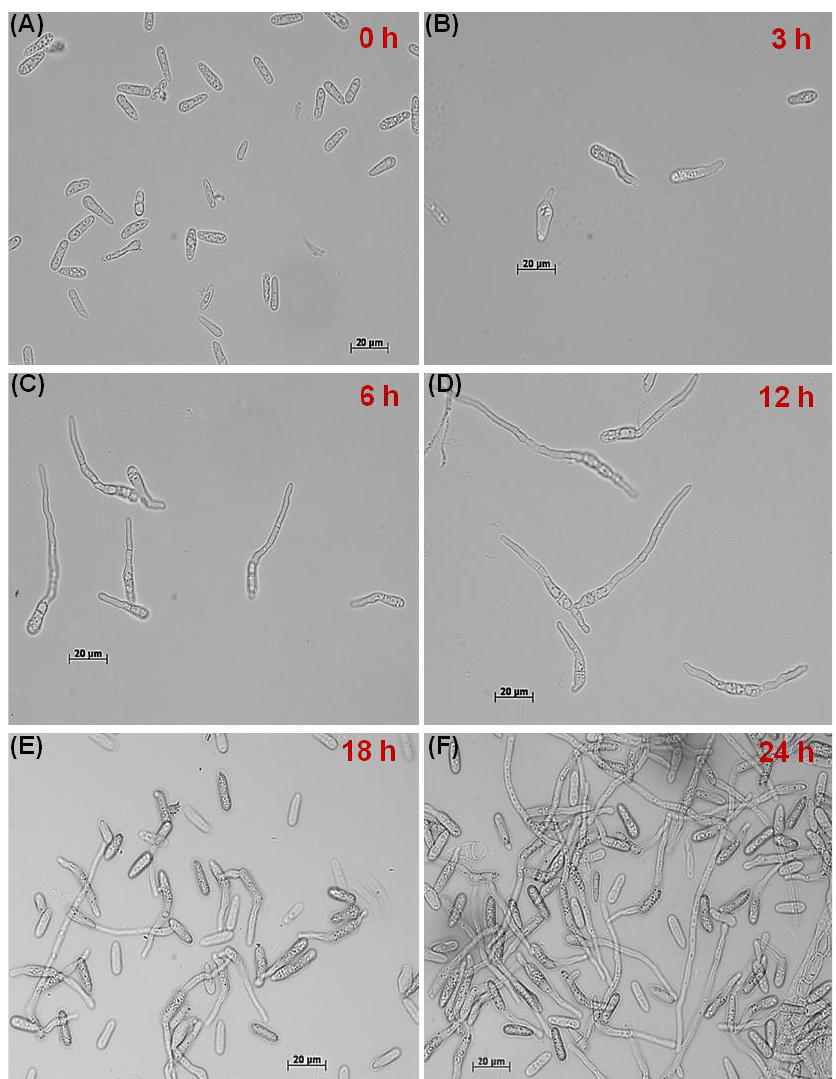
Figure 2. Different stages of GT formation at different time points in C. gloeosporioides in vitro. ( A ) Swelling and adhesion of conidia. ( B ) GT initiation. ( C – E ) GT elongation. ( F ) Hyphal network. Scale Bar = 20 μm.